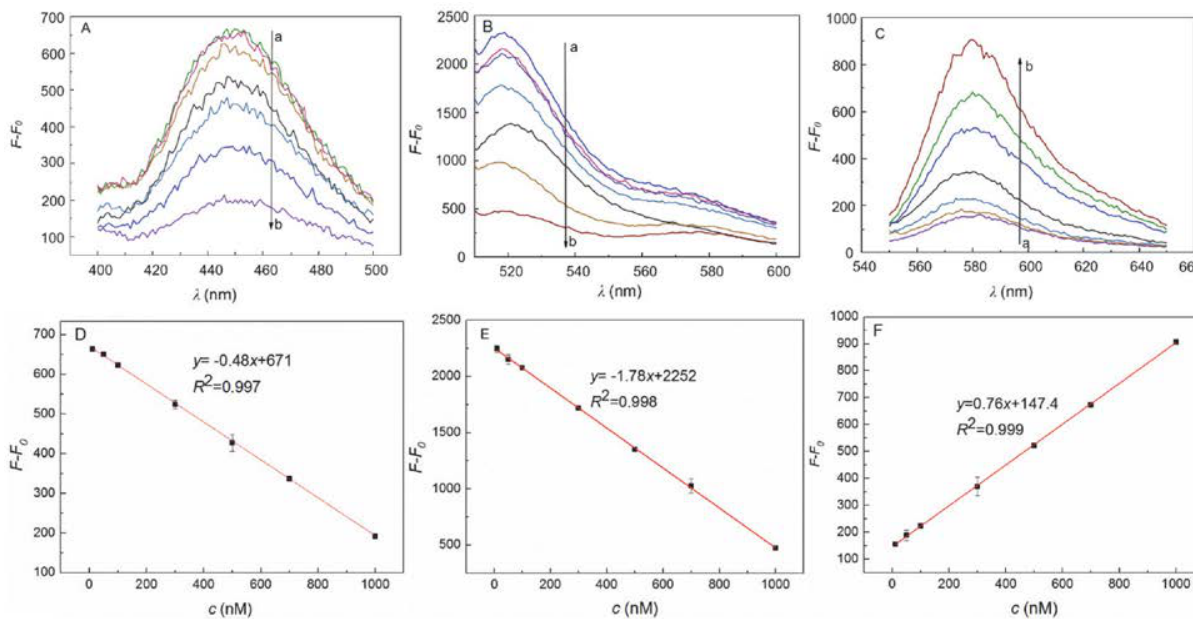
Figure 5. Fluorescence emission spectra of (A) Pb 2+ ( λ ex = 353 nm, λ em = 450 nm), (B) Ag + ( λ ex = 495 nm, λ em = 517 nm), and (C) Hg 2+ ( λ ex = 530 nm, λ em = 580 nm), and standard curves of (D) Pb 2+ , (E) Ag + , and (F) Hg 2+ in the concentration of (a~b) 10, 50, 100, 300, 500, 700, 1000 nM. F is measured fluorescence intensity,